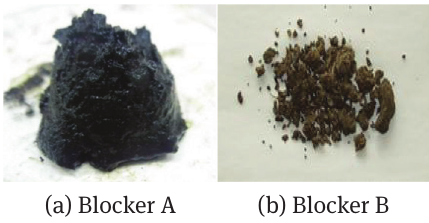
Figure 1: Polymer blockage in loose sandstone.